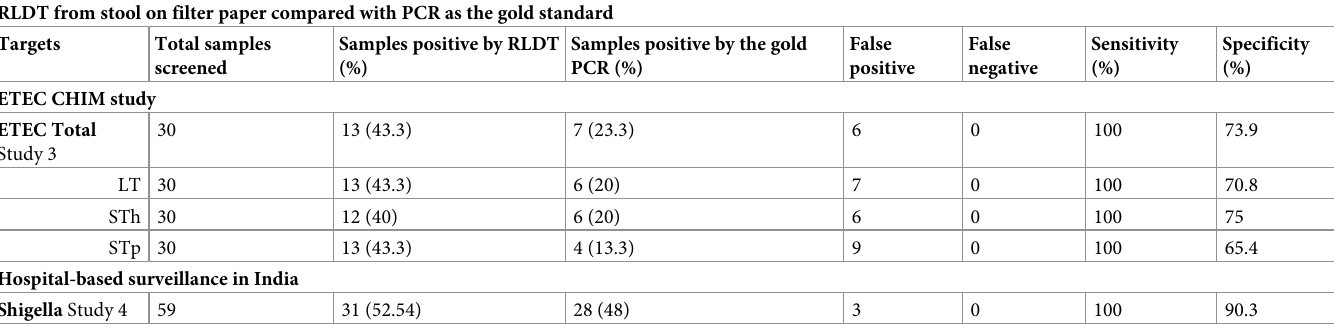
Table 4. Sensitivity and specificity of ETEC and Shigella RLDT from the stool on filter paper compared to conventional PCR. RLDT from stool on filter paper compared with PCR as the gold standard